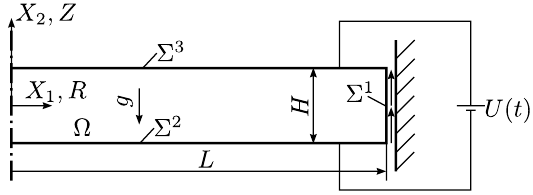
Figure 2. Illustration of example problem